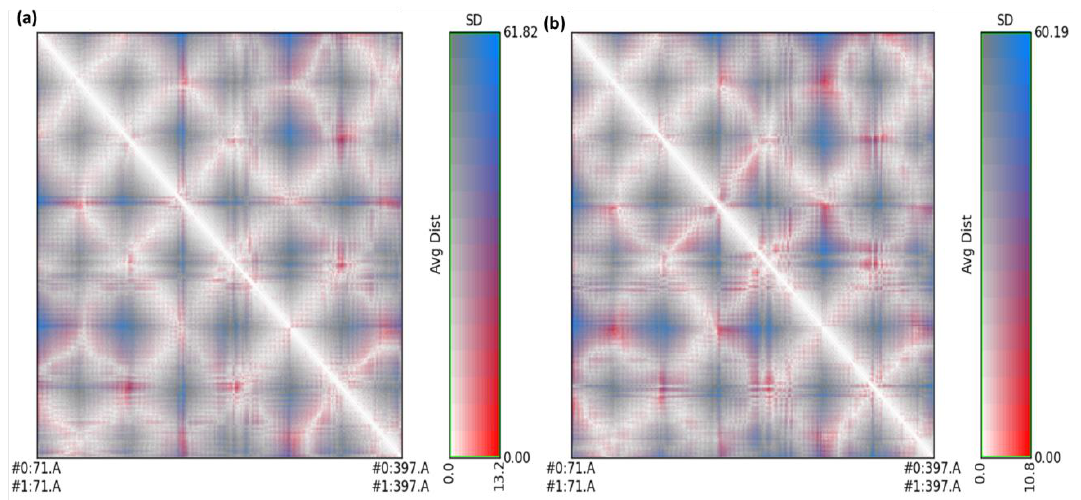
Figure 12. RR distance map between ( a ) unbounded serotonin and [(FXN)(PA)]–serotonin after simulation; ( b ) unbounded serotonin and (FXN)–serotonin after simulation. Average distance and standard deviation were included and calculated for all amino acid pairs.